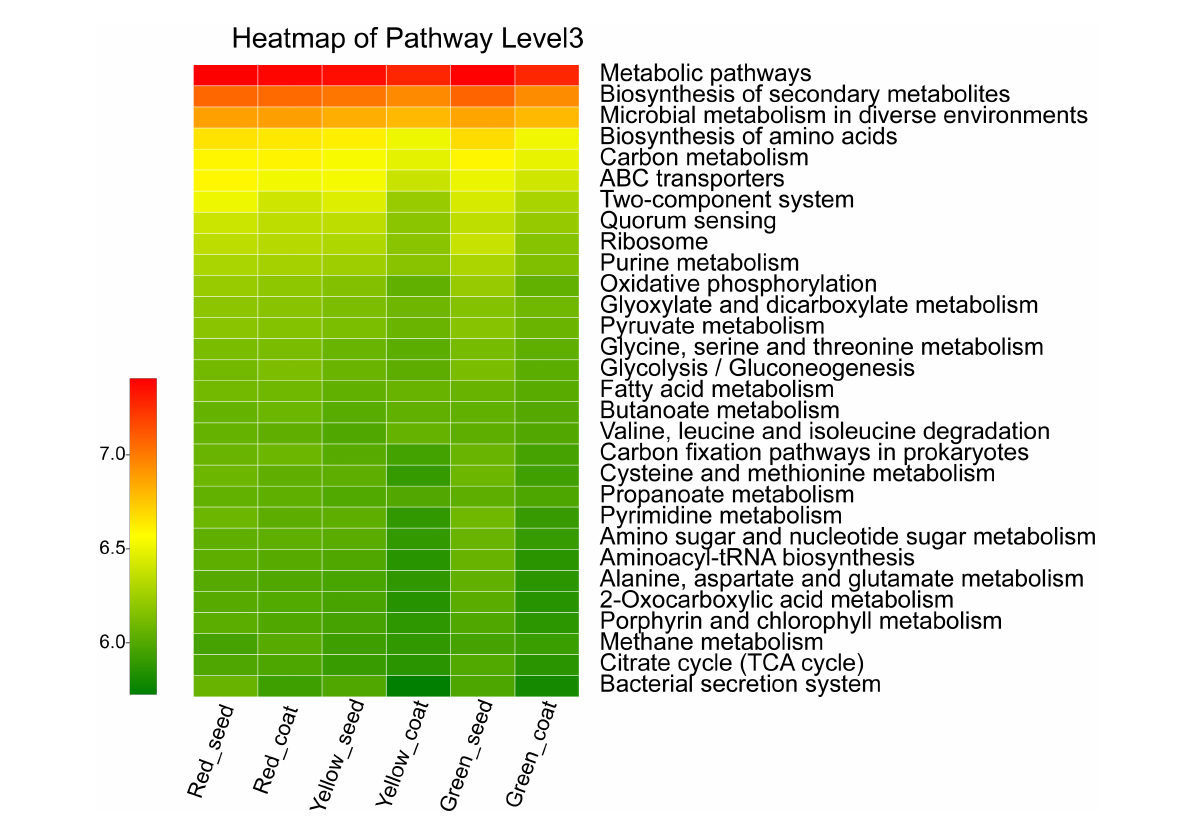
FIGURE6 Heatmap of the relative abundances of the top 30 PICRUSt-predicted genes in the different treatments ( n = 3/treatment). The abscissa is the treatment, and the ordinate is the function name of pathway level 3. The color gradients of different color blocks represent the changes in different functional abundances in the treatments. The legend is the value represented by the color